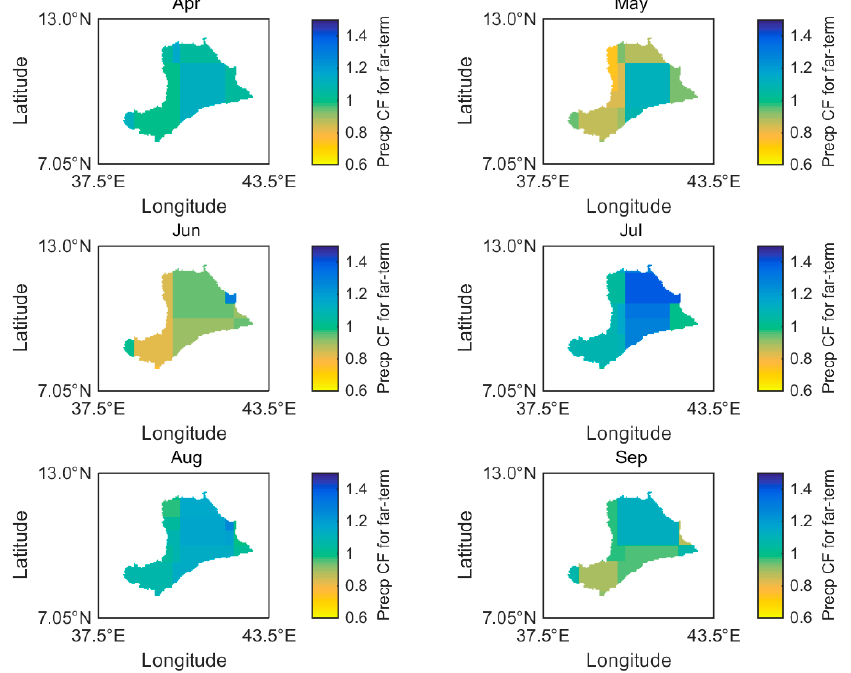
Figure 8. Precipitation change factors for April to September months for the far-term period, 2056–2080 (based on the median of the three models).